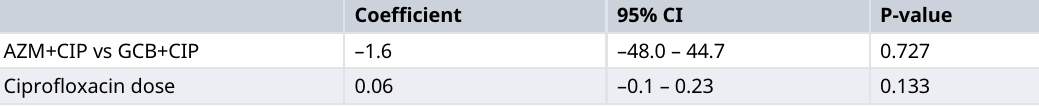
Table 3. Linear regression analysis of the effect of sequential azithromycin – ciprofloxacin (AZM+CIP) versus GC broth – ciprofloxacin (GCB+CIP) on time to the genesis of ciprofloxacin resistance (defined as MIC 0.032 mg/L). (AZM: Azithromycin; GCB: Gonococcal broth; CIP: Ciprofloxacin; MIC: Minimum inhibitory